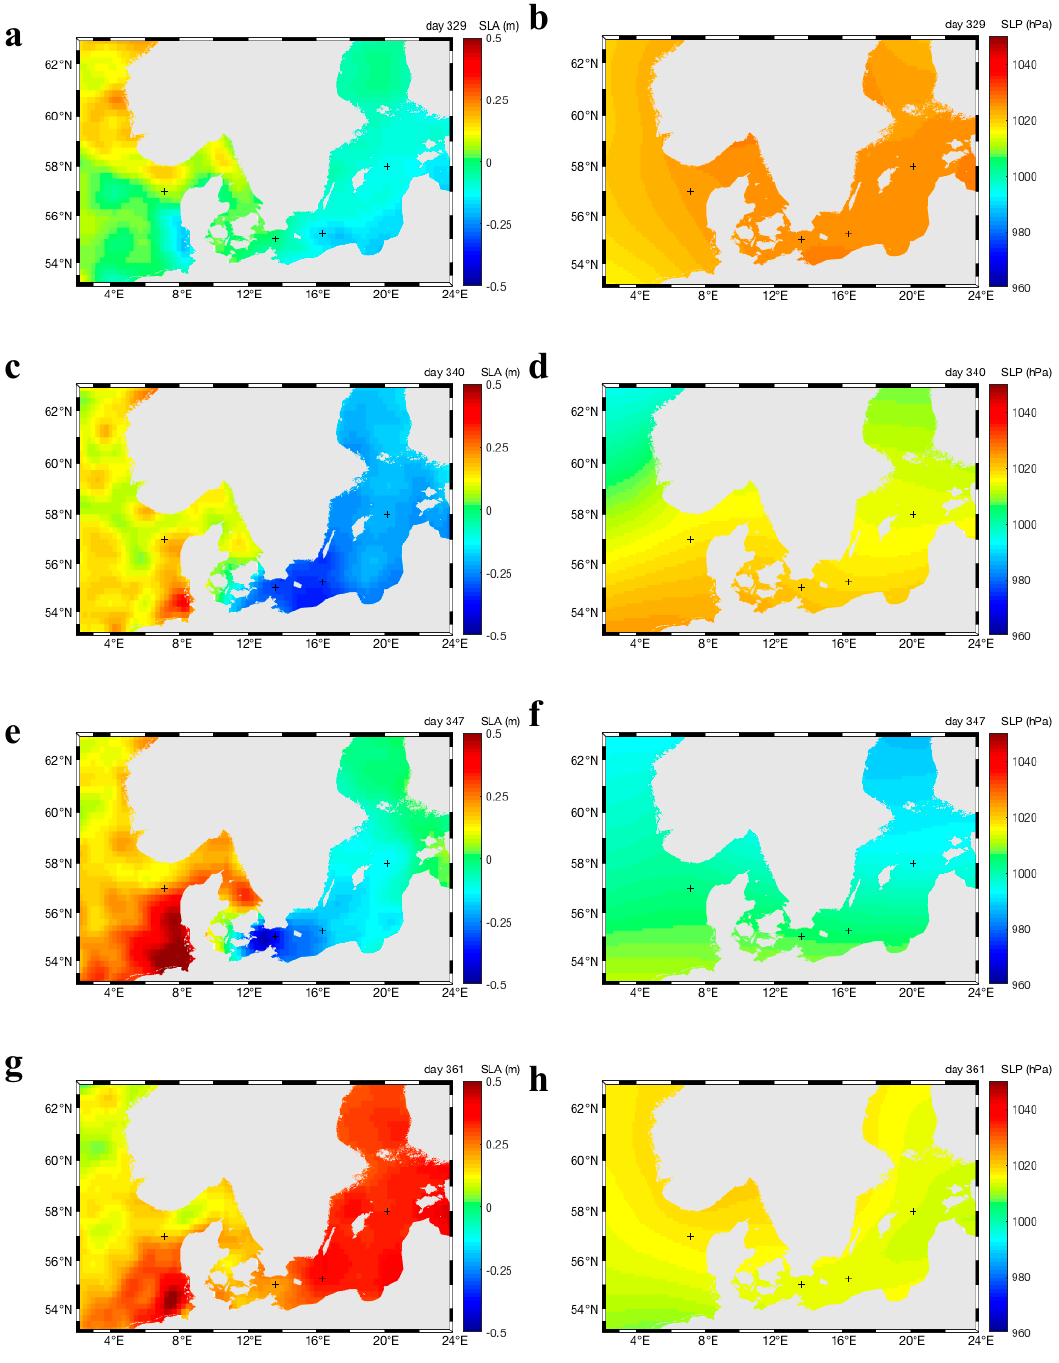
Figure 3. Maps of sea level anomalies (column on the left side) and atmospheric pressure at sea level (column on the right side) during the MBI event in 2014. Data are shown for selected days (329, 340, 347, and 361). Crosses indicate pixels 1–4.